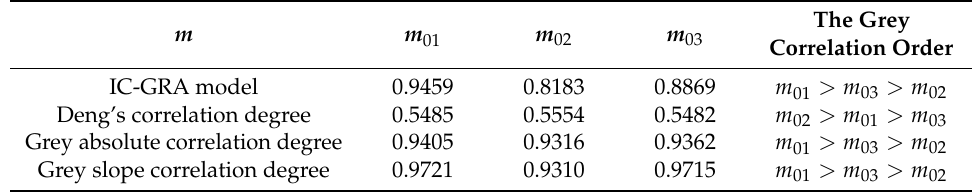
Table 1. Comparison of the several grey correlation degrees.